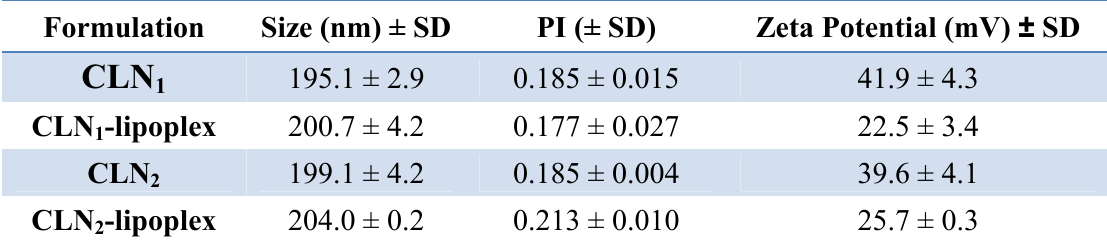
Table 3. Characterization (Size, Polydispersity Index (PI) and Zeta Potential) of CLNs